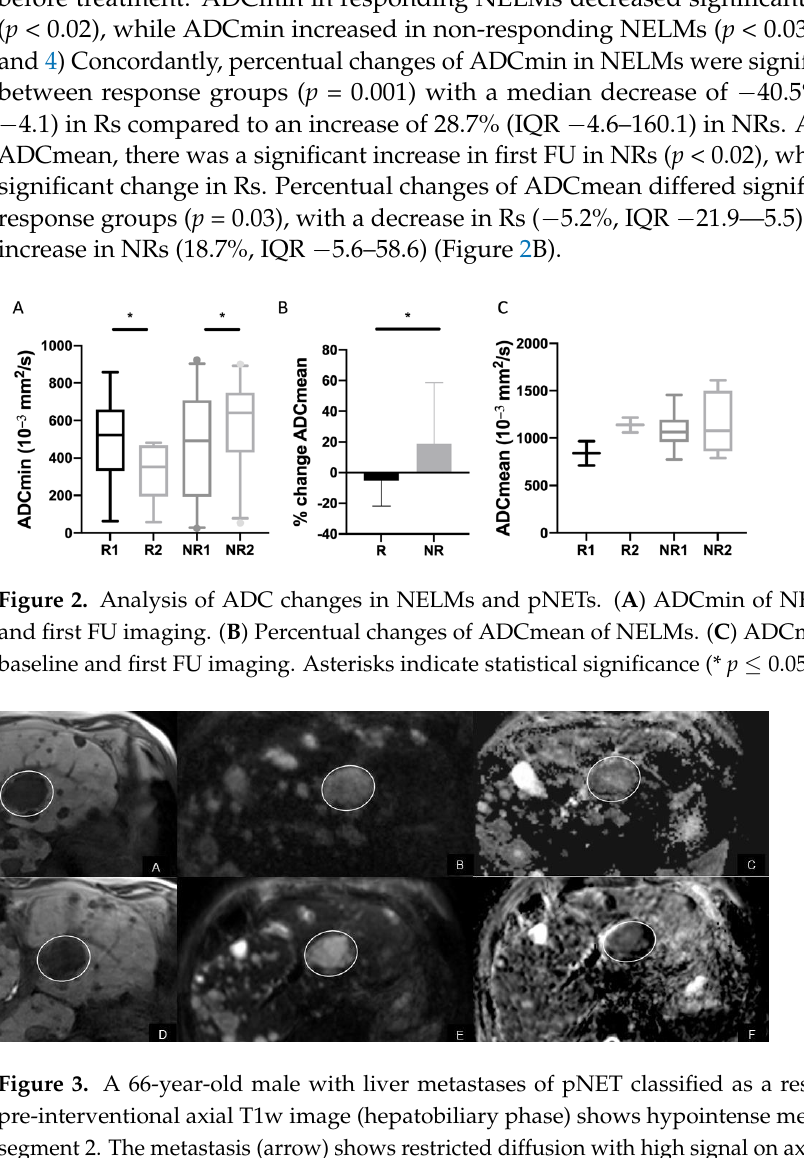
Figure 4. An 74-year-old man with hepatic metastasis of pNET classified as a nonresponder. ( A , D ) Under everolimus, the metastasis (arrow) increased in size from ( A ) 25 mm to ( D ) 29 mm on the axial contrast-enhanced T1W image (liver-specific phase) ( B , D ). On both ( B ) pre- and ( D ) postther- apeutic MRI, the metastasis (arrow) showed restricted diffusion with high signal on DWI image with high b-value. ( C ) ADCmin value of the metastasis (circle) on pretherapeutic ADC map ( E ) was 747 × 10 −3 mm 2 /s and increased to 811 × 10 −3 mm 2 /s on ( F ) the post-therapeutic scan. Regarding the primary tumor, statistical analysis was limited due to the small sample size. In Rs, both ADCmin and ADCmean tended to increase after therapy initiation, while there was no change in NRs (Figure 2C). For ADCmean, percentual change was 37.1% (IQR 25.6 – 48.5) in Rs compared to 1.2% (IQR −1 3.4 – 25) in NRs. There were no significant changes between the pre- and posttherapeutic ADCmean of non-tumorous liver, spleen, and pancreatic tissue. 3.4. T2 Signal T2w of NELM divided by the T2w background signal of the spleen (T/S ratio) in- creased significantly in NRs while there was no change in Rs (Figure 5).